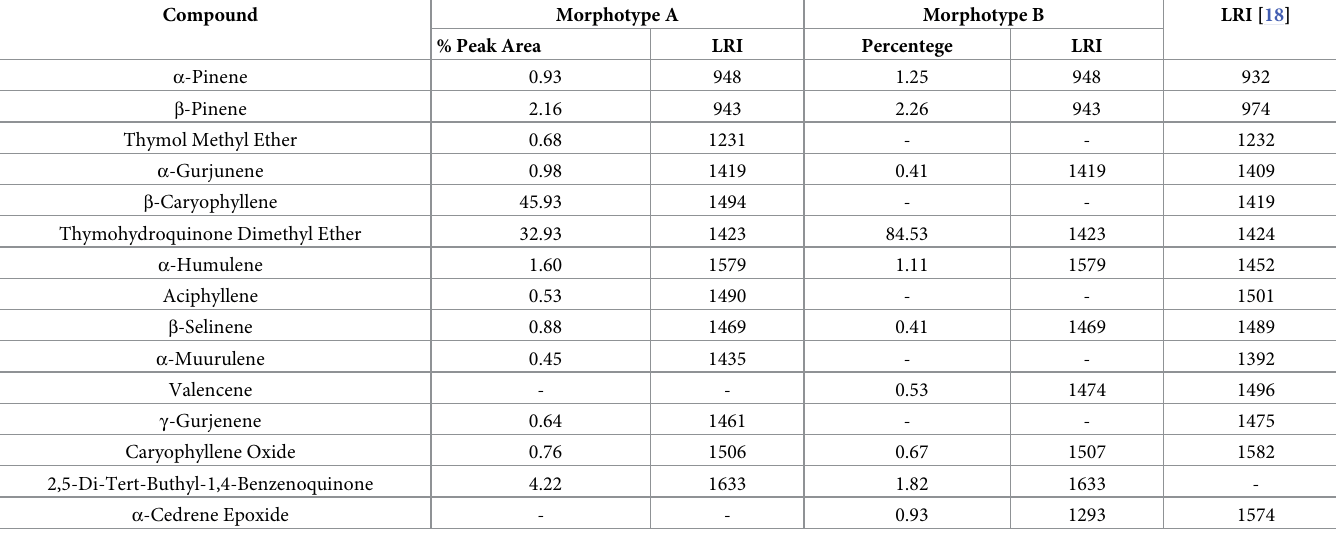
Table 1. Chemical composition of essential oils of A . triplinervis morphotypes A and